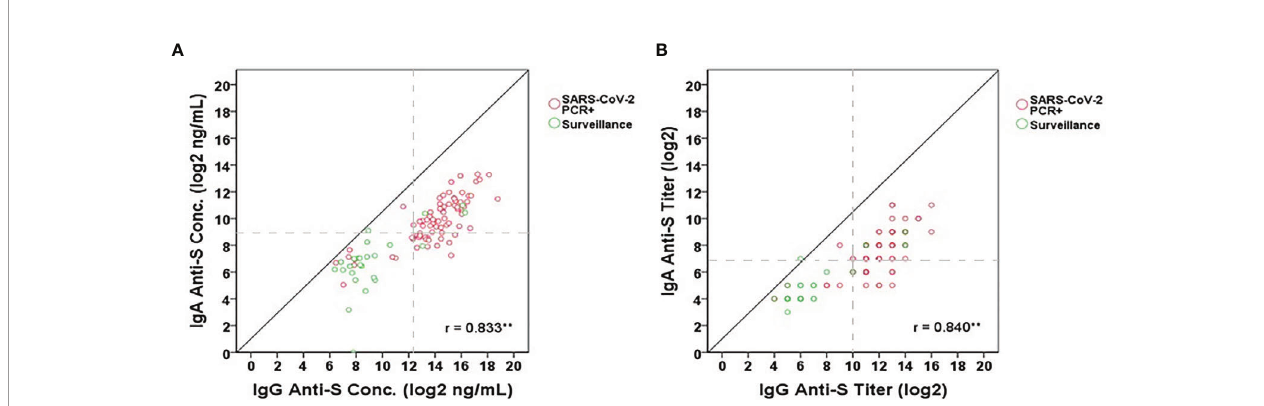
FIGURE 3 | Correlation between IgG anti-S and IgA anti-S (A) concentrations (log2 ng/mL) and (B) titers (log2) in SARS-CoV-2 PCR positive (red open circles) and pandemic surveillance sera (green open circles). Gray dash lines represent the cut-offs of antibody titers (log2) or concentrations (log2 ng/mL). Pearson ’ s correlation coef fi cient was calculated to measure the strength of the linear association. *Correlation was signi fi cant at the 0.05 level (2-tailed). **Correlation was signi fi cant at the 0.01 level (2-tailed). A total of 101 serum samples including 76 from SARS-CoV-2 PCR positive adults and 25 from adults who participated in pandemic surveillance study were tested by each